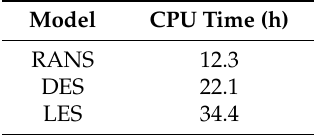
Table 2. Comparison of computation time with di ff erent models (3.4 GHz, 2